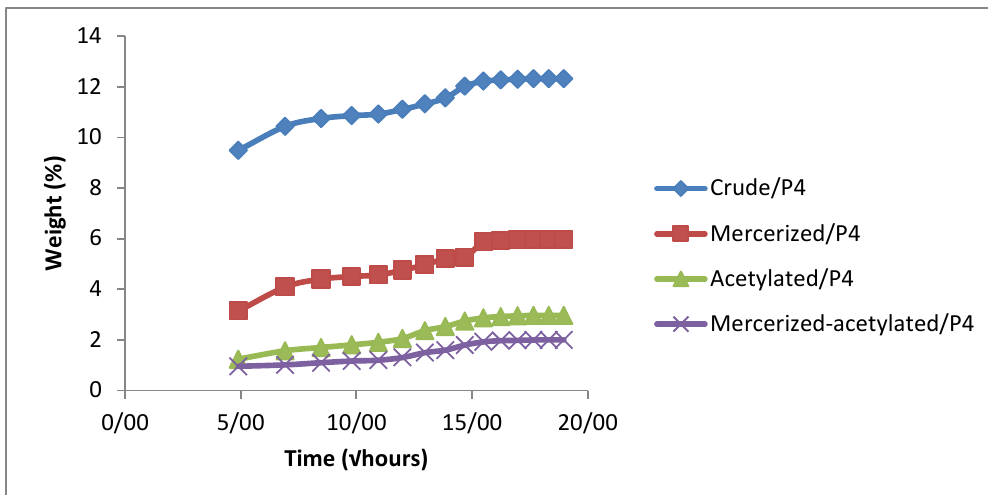
Fig. 4. Moisture absorption behaviour over time for P4 fibre